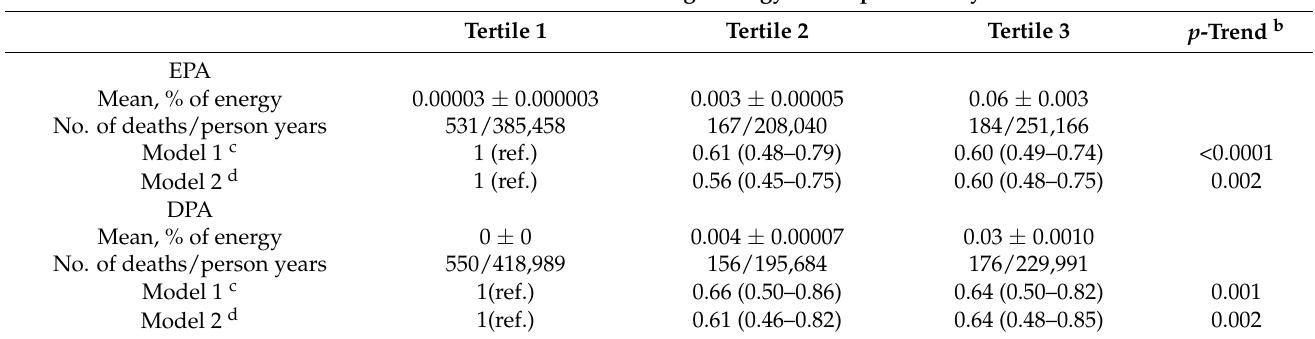
Table 3. Cont . Tertiles of Percentage Energy from Specific Fatty Acids